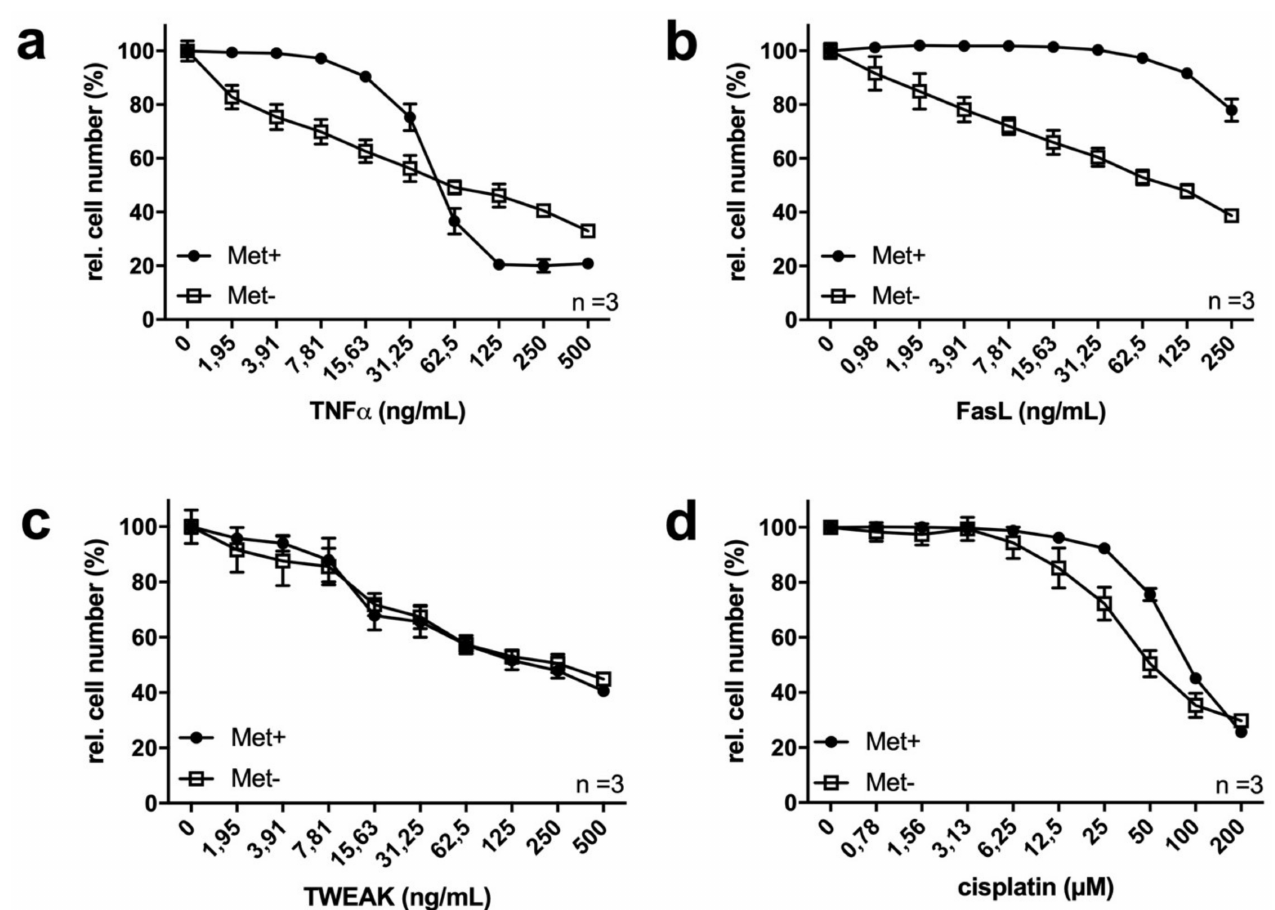
Figure 2. ( a – d ) Methionine restriction sensitizes L929 cells to TNF α ligands and cisplatin. A total of 10,000 cells/well were seeded, incubated overnight and then stimulated for 72 h with or without methionine in combination with TNF α ( a ), FasL ( b ), TWEAK ( c ) or cisplatin ( d ). Cell proliferation was analysed by crystal violet staining as described in the Materials and Methods. The figures show a summary of the results from three independent experiments. The control was normalized to